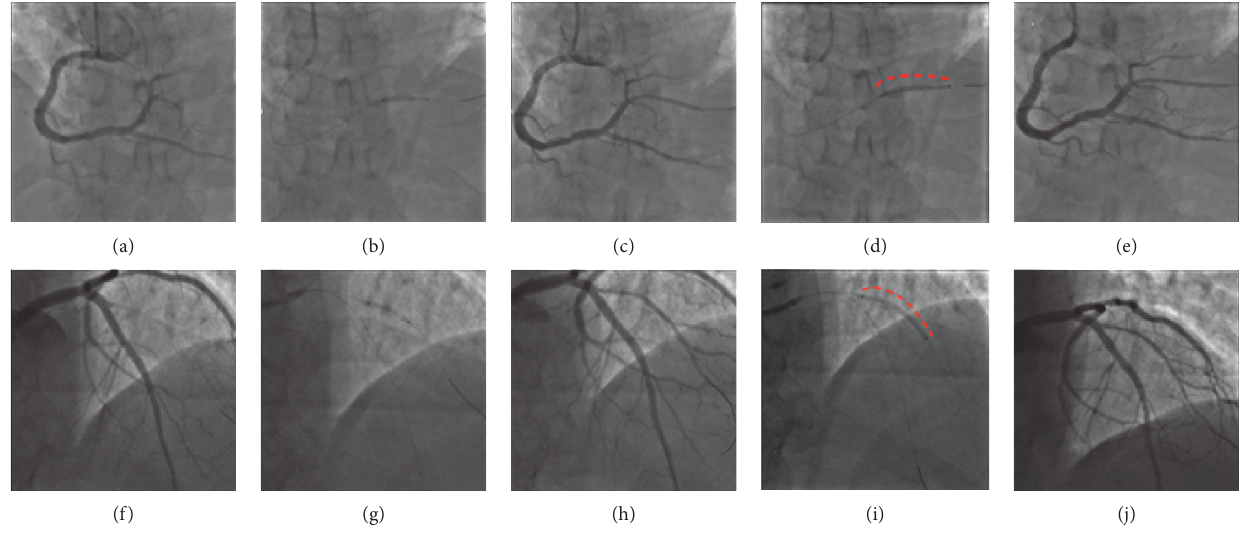
Figure 1: STEMI patients undergoing PCI with the SCB of de novo lesions in small vessels. Upper panels ((a)–(e)): total thrombotic occlusion of proximal posterolateral branch of the RCA (a) in a patient with inferior STEMI treated with a 2.25 × 12mm balloon ((b) and (c)) and 2.25 × 30mm SCB (d) with good TIMI 3 final result (e). Lower panels ((f)–(j)): total thrombotic occlusion of proximal first diagonal branch (f) in a patient with lateral STEMI treated with a 2.25 × 15mm balloon ((g) and (h)) and 2.25 × 30mm SCB (i) with good TIMI 3 final result (j).